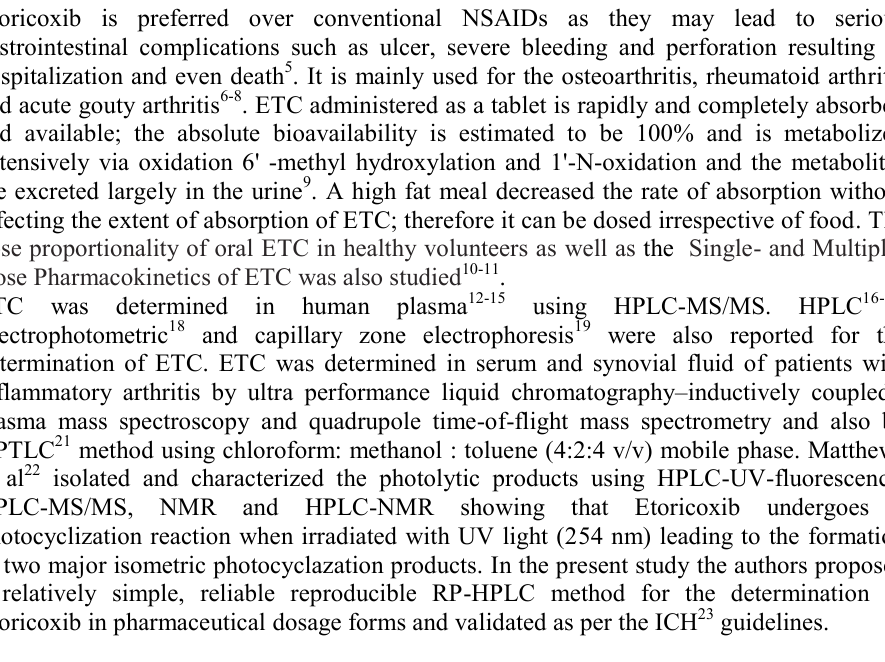
Figure 1. Chemical Structure of Etoricoxib